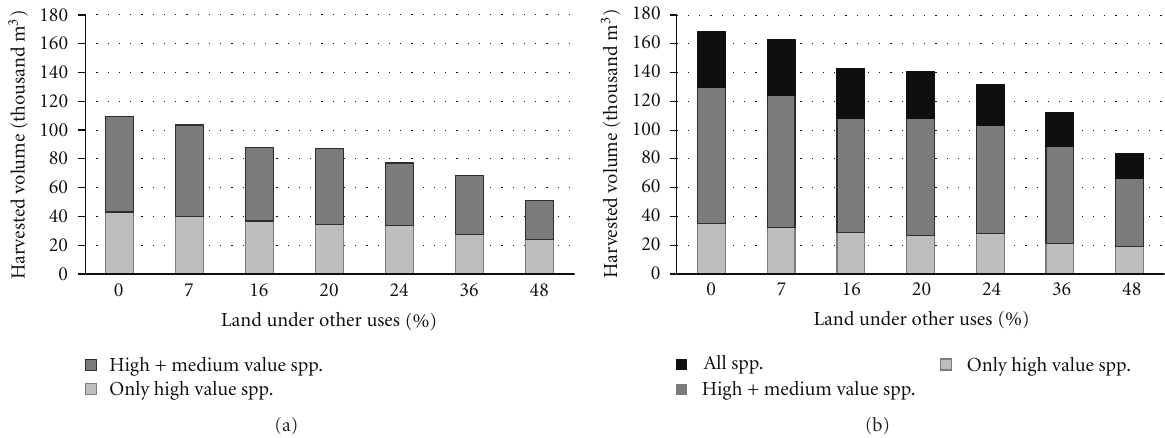
Figure 3: Volume harvested within Faro State Forest by timber value class with an increasing number of stands converted to other land uses from current logging centers (a) and from closer urban centers